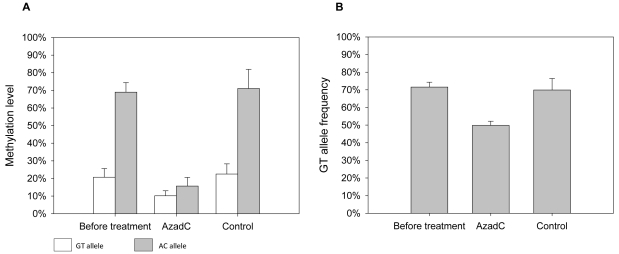
Treatment of LCL C0913 with AzadC.
A: The ASM of LCL C0913 is shown before and following treatment with 5 µM AzadC. Mean methylation levels decreased from 20.7±4.9% to 10.2±2.8% for the GT allele and from 69±5.4% to 15.7±4.9% for the AC allele. Mean methylation level in the control cells did not change, that is, GT allele showed 22.5±5.8% and the AC allele 71.1±10.9%. B: ASE of LCL C0913 subjected to AzadC treatment. Allele frequencies were obtained by pyrosequencing of cDNA. Untreated cells showed allelic, that is more expression from the less methylated GT allele. By contrast, the allele frequency of the GT allele diminished from 71.6±2.8% to 49.9±2.3% following AzadC treatment. The control cells showed a GT allele frequency of 69.9±6.5%.